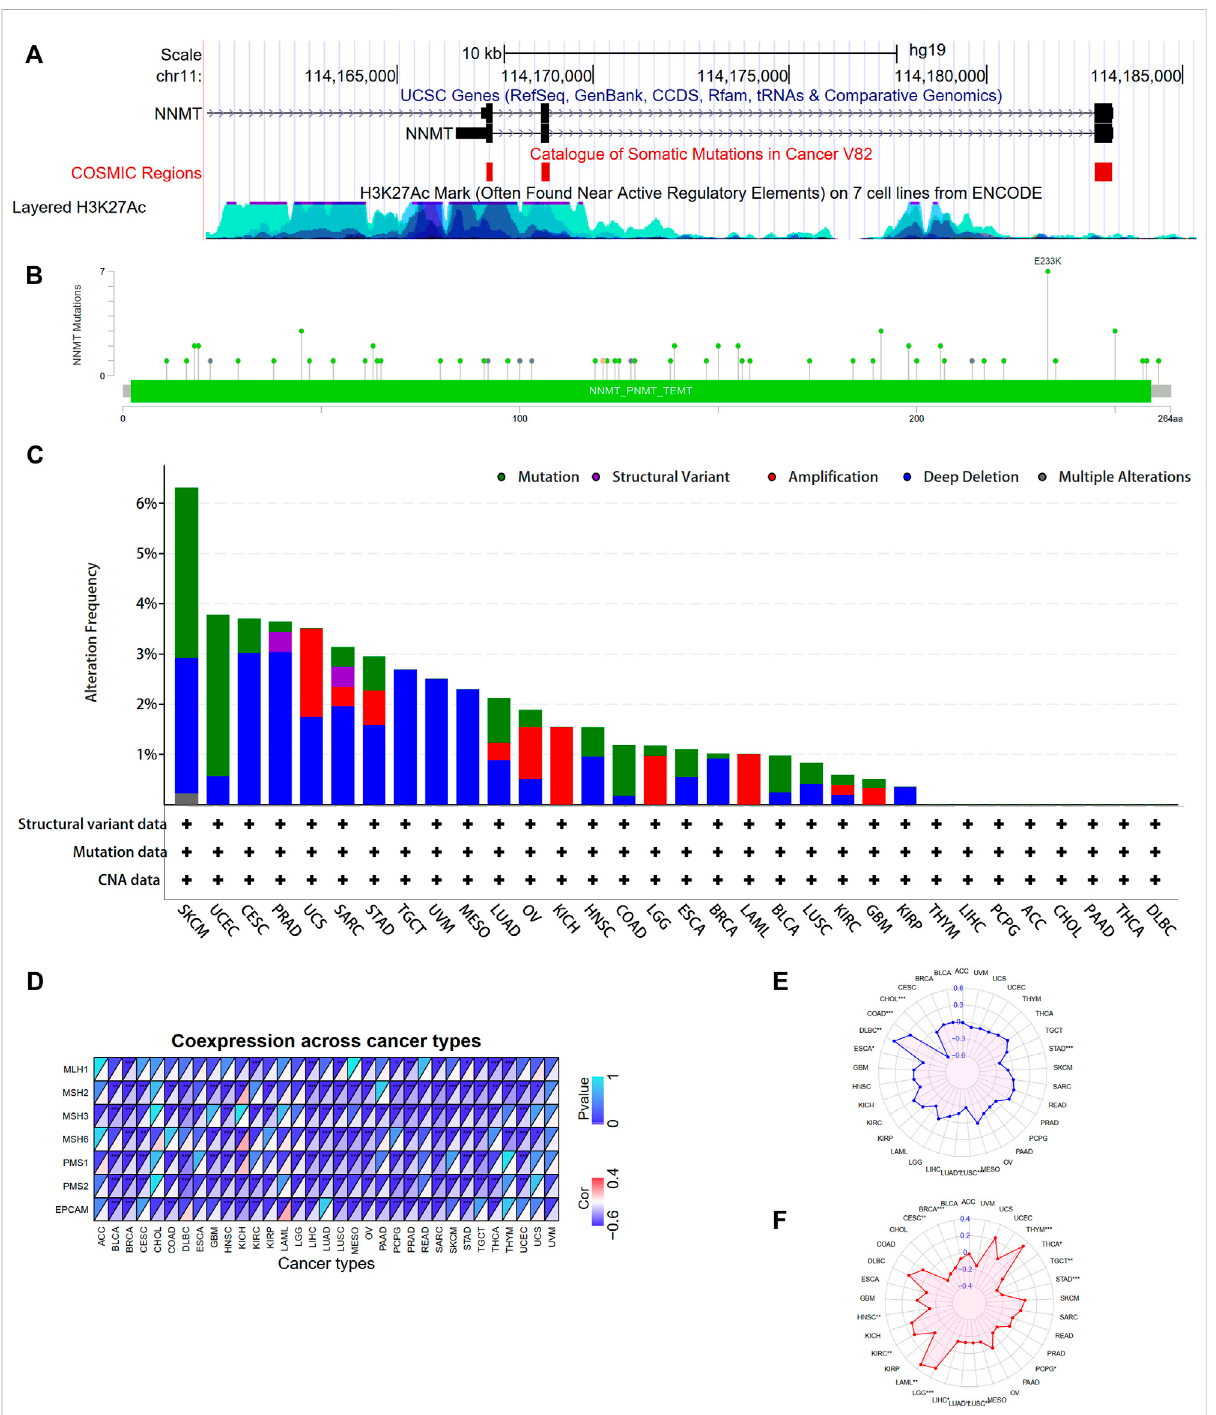
FIGURE 10 NNMT gene mutation analysis and associations between NNMT expression and mismatch repair (MMR), microsatellite instability (MSI) and tumor mutational burden (TMB). (A) NNMT gene mutation sites and epigenetic modi fi cations were visualized using the UCSC genome browser. NNMTgeneticalterationinvarioustumortypesofTCGA.ThealterationfrequencywithNNMTgeneticalterationtype (B) andNNMTmutationsite (C) weregeneratedbycBioPortal. (D) NNMTexpressionwassigni fi cantlyandhighlyconnectedwithMMRgeneexpressioninthemajorityofcancer types (except ACC CHOL and UVM); MSH2 MSH3 PMS1 and PMS2 were negatively correlated with NNMT in the majority of cancer types. (E) The expressionofNNMTwasinverselyconnectedwithMSIinCHOL,ESCA,LUAD,LUSC,andSTAD,butpositivelycorrelatedwithCOADandDLBC. (F)